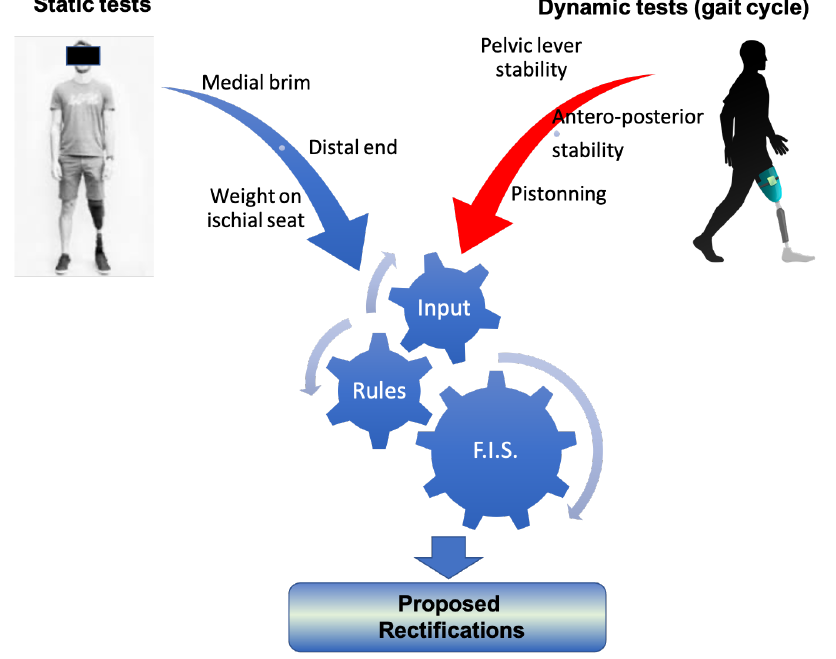
Figure 5. The classification of rectification